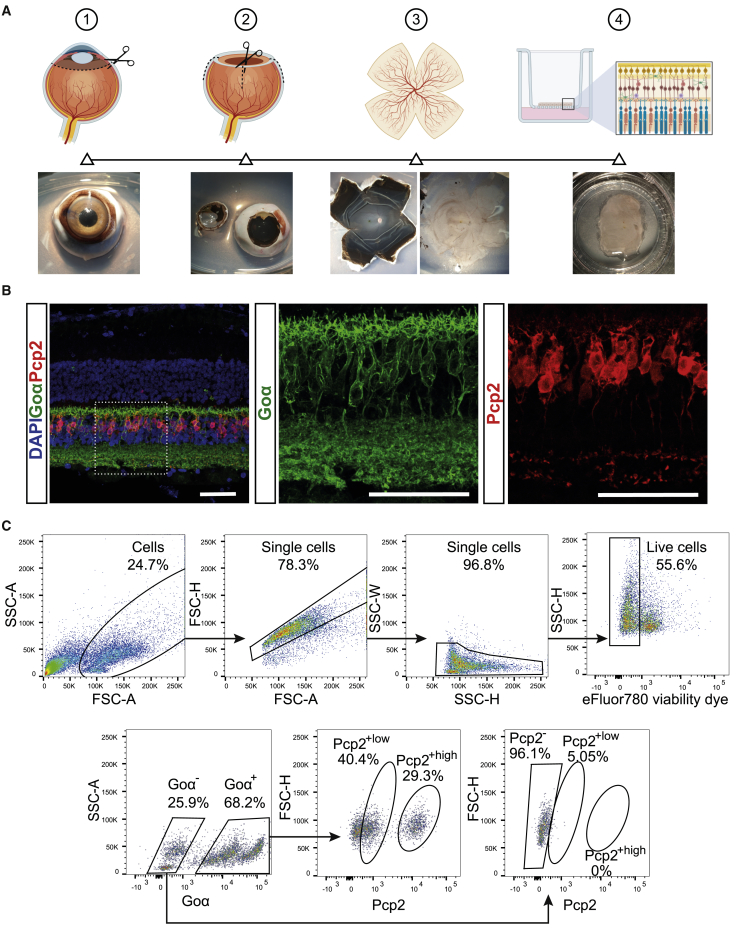
Isolation of ON bipolar cells from NHP retina after overnight culture(A) Graphical representation of the retinal explant preparation accompanied by sample images. (B) Confocal microscopy images of IHC-labeled NHP retina, showing the expression of ON bipolar cell markers Goα and Pcp2, whose localization is better observed in the adjacent magnified panels. Scale bars, 50 μm. (C) Representative FACS dot plots depicting the initial gating strategy for sorting only viable single cells. The preparation of the samples is exemplified in Figure S2. (D) Representative FACS dot plots showing the sorting gates based on Goα and Pcp2 expression and the representation of the four sorted populations (Goα−/Pcp2−, Goα+/Pcp2+low, Goα−/Pcp2+low and Goα+/Pcp2+high).